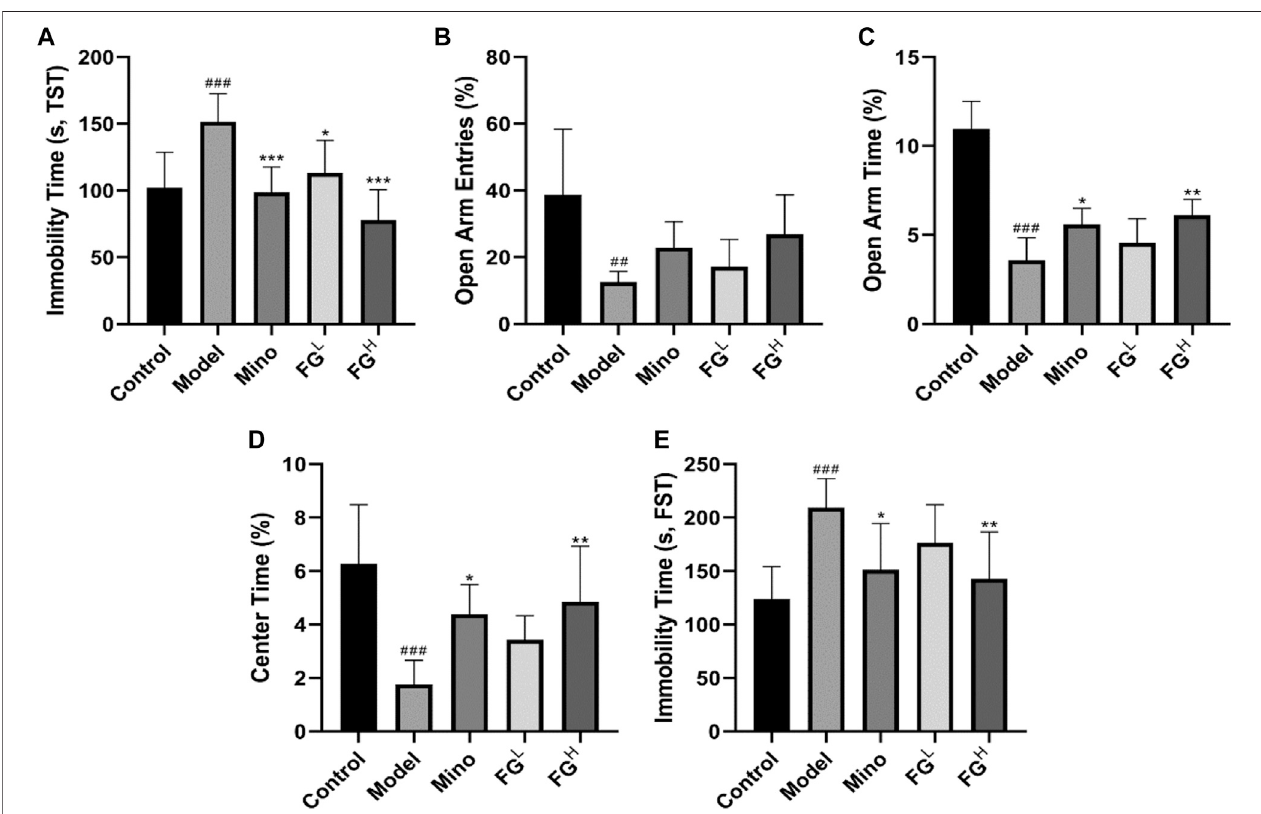
FIGURE 10 | Effects of FG on fatigue-like behaviors in CRF model mice. Mice were treated with the corresponding drugs or normal saline 7 days after the inoculationof4T1cells.ControlandModelgroup:theequivalentamountofnormalsaline;Minogroup:minocyclineatadoseof50 mg/kg/d;andFG L andFG H group:FG extraction at the doses of 4 and 16 mg/kg/d. The fatigue-like behaviors of mice in each group were evaluated three times per week. (A) Locomotor activities of mice in spontaneouslocomotoractivitytest. (B) Residencetimeofmiceinrotarodfatiguetest. (C – D) Normalizedpeakforcemeasurements(PFM)andnormalizedaverage forcemeasurements(AFM)ofmiceingripstrengthmeasurementstest. (E) Swimmingtimeofmiceinweight-loadedswimmingtest.Resultsareexpressedasmean ± SD ( n (cid:2) 6 – 12, # p < 0.05, ## p < 0.01, ### p < 0.001 compared with control group; * p < 0.05 compared with model